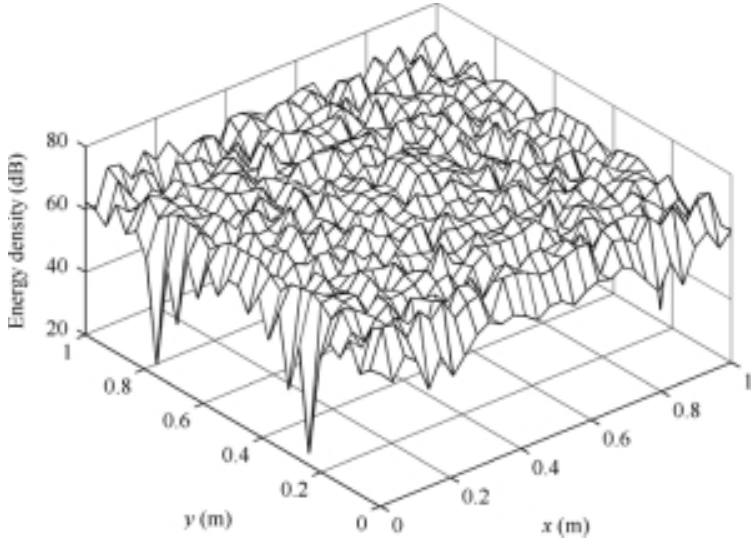
Fig. 11. The classical energy density distribution of the orthotropic plate when f = 5 kHz and η = 0 . 02 . The reference energy density is 1 × 10 − 12 J/m 2 .